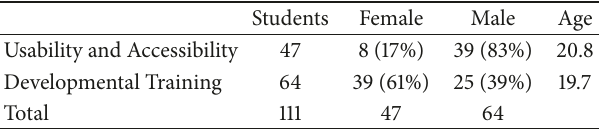
Table 1: Enrolled